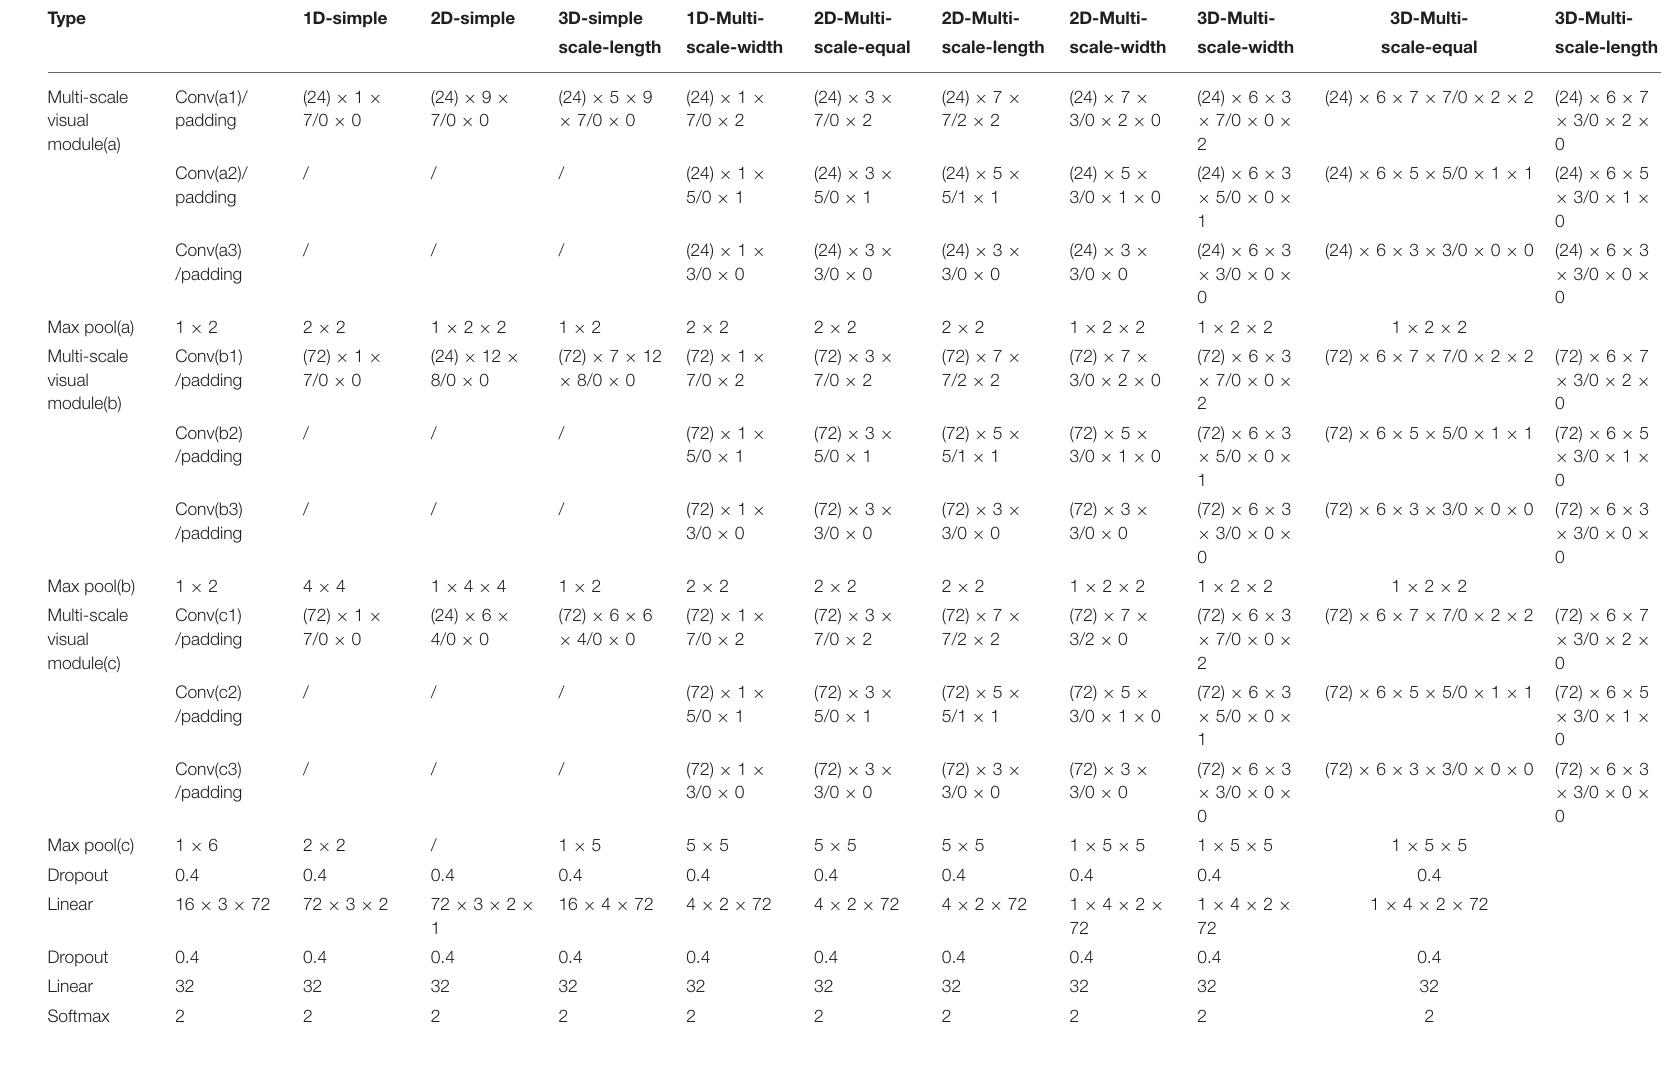
TABLE 1 | Architecture of main neural networks for EEG